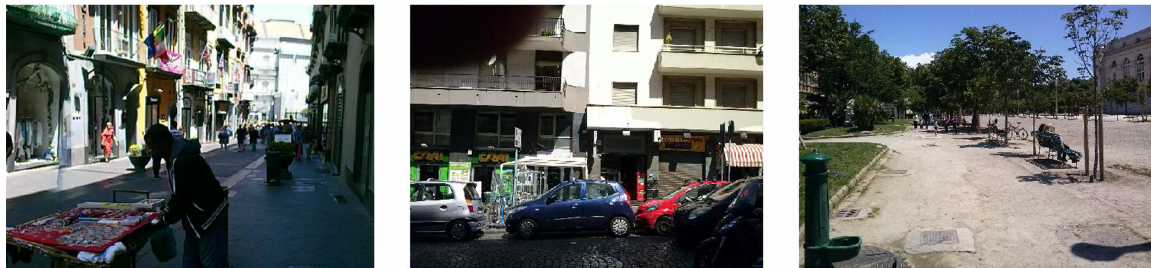
Figure 3: Interior areas; from left to right: pedestrian areas (code Int_PE), open to road traflc areas (Int_TR) and green areas (Int_Park).